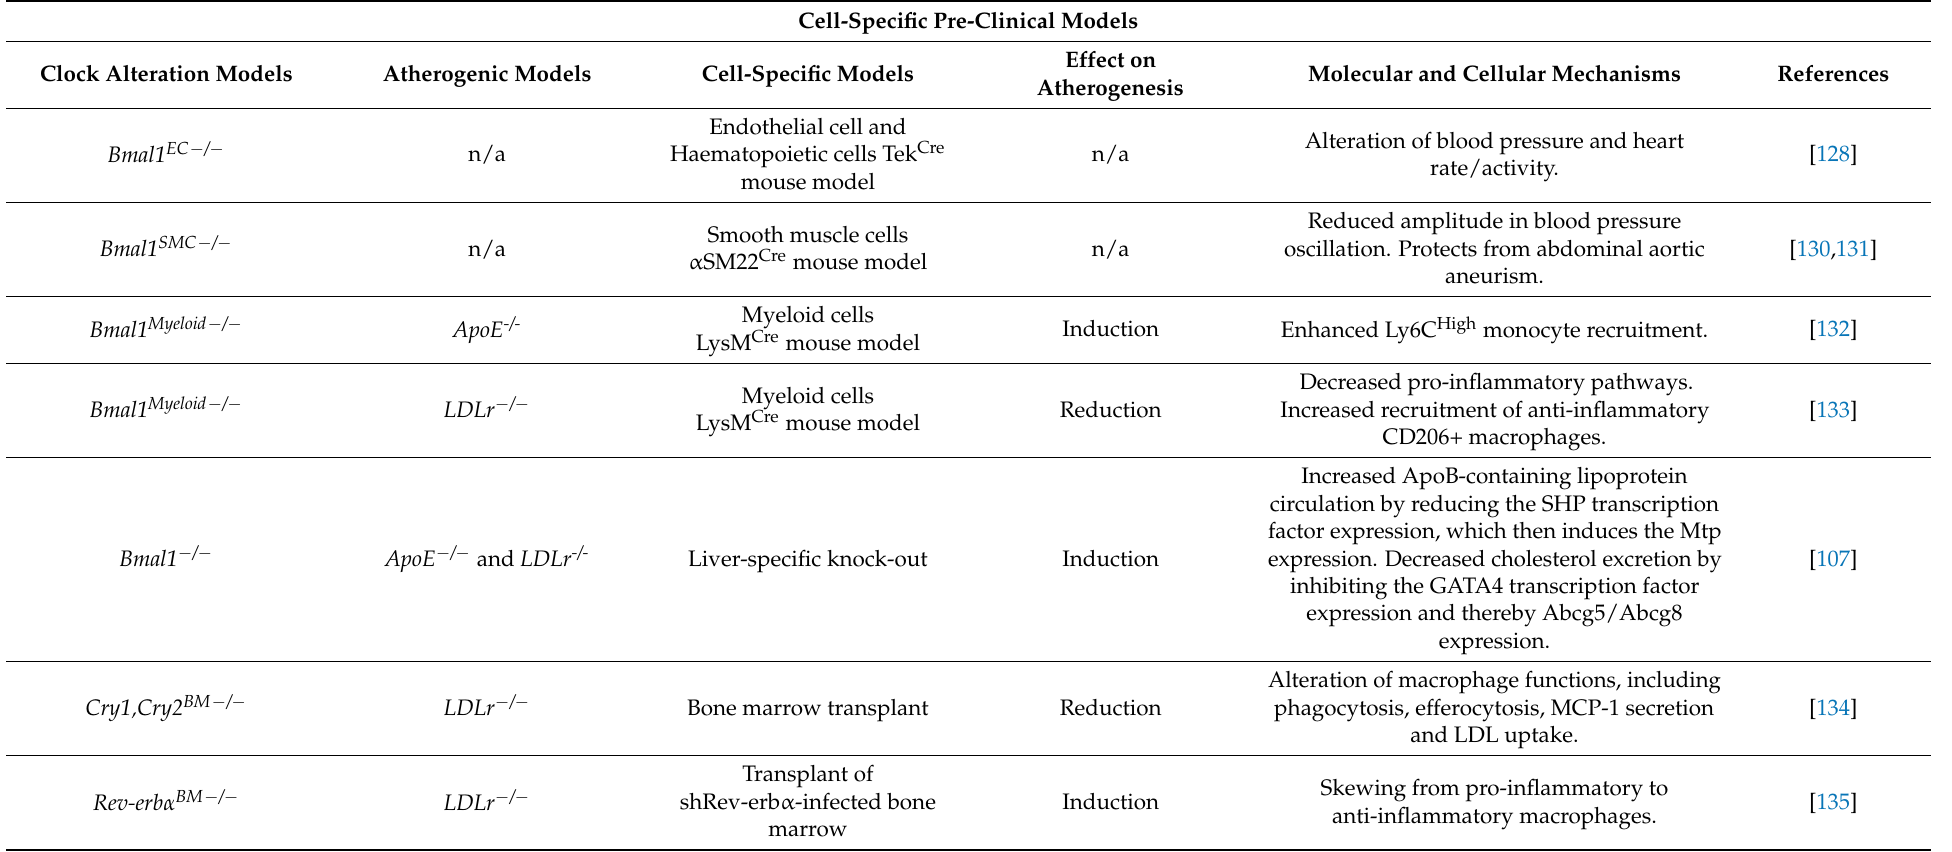
Table 3. Pre-clinical models of cell-specific clock